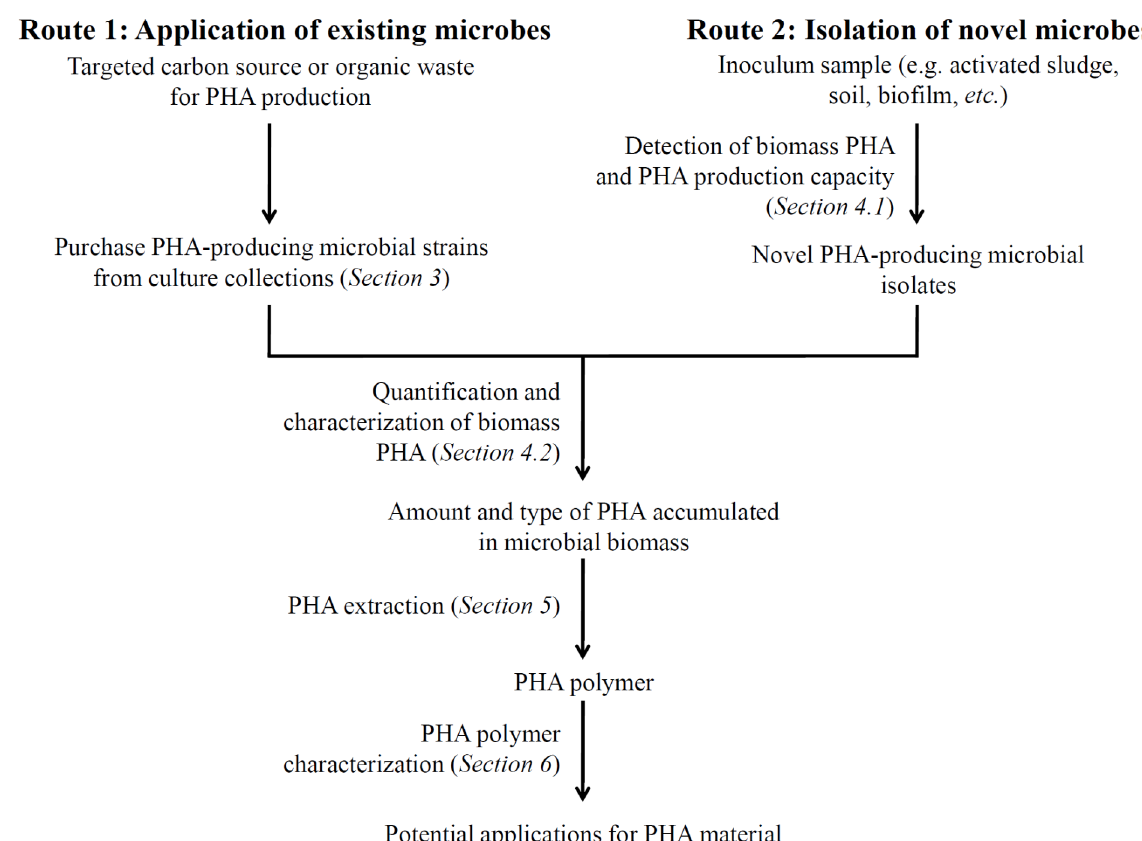
Figure 2. Schematic workflow processes for PHA